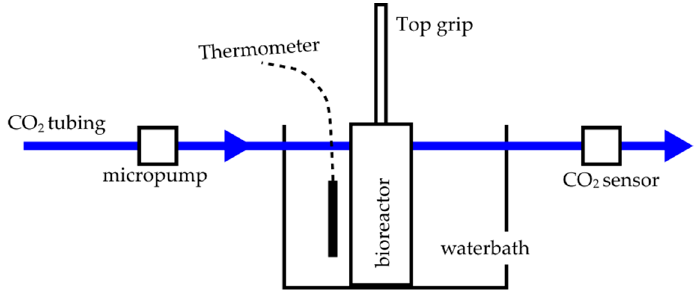
Figure 1. Diagram and connection array of the biomechanical stimulation system.